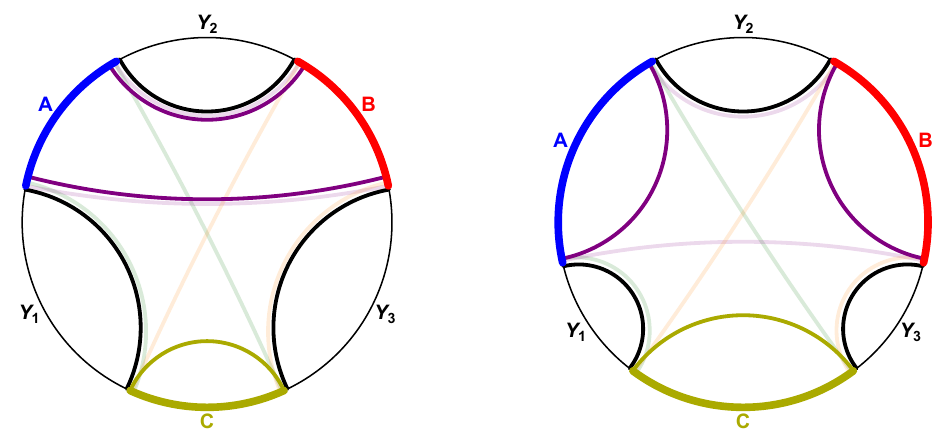
Figure 9 . The winning strategies that arise from auxiliary geometry I (left) and geometry II